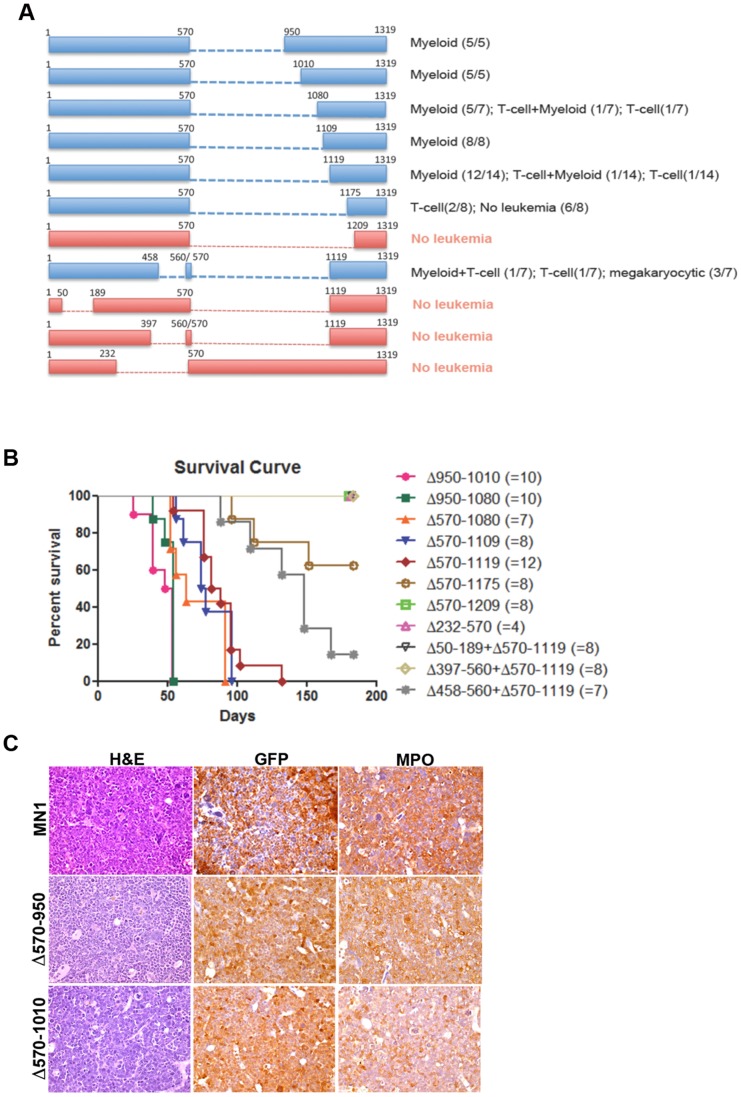
Kaplan-Meier survival curves of mice receiving MN1 or mutant MN1-transduced bone marrow.(A) Schematic representations of MN1 deletion mutants. Mutants depicted in blue do cause leukemia, while mutants in red do not. Leukemia types generated by each mutant are indicated in the Figure. Stippled lines indicate the size of MN1 deletions. (B) Comparison of Kaplan-Meier survival curves of mice receiving transplants of bone marrow transduced with the indicated MN1 deletion mutants. (C) Histological analysis of a bone marrow sample of a representative leukemic mouse in each indicated group. Images were taken at 400X using an Olympus BX41 microscope, equipped with an Insight 2 Mega-pixel Color Mosaic camera, employing SPOT advanced imaging software. H&E = hematoxilin & eosin staining, GFP = green fluorescent protein staining, MPO = myeloperoxidase staining.